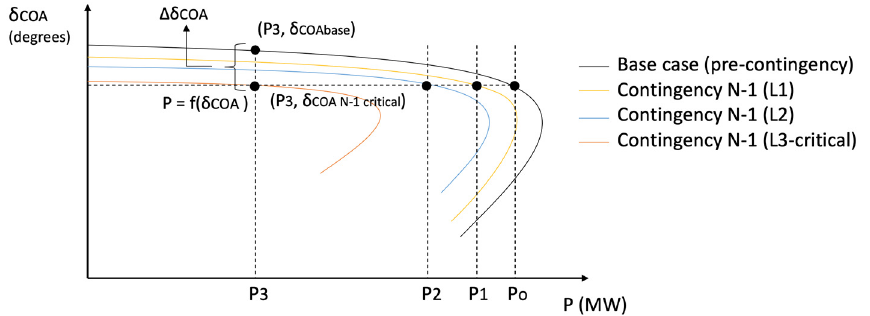
Figure 7. Determination of the angular index for different demand scenarios with voltage limit (0.9 p.u.).